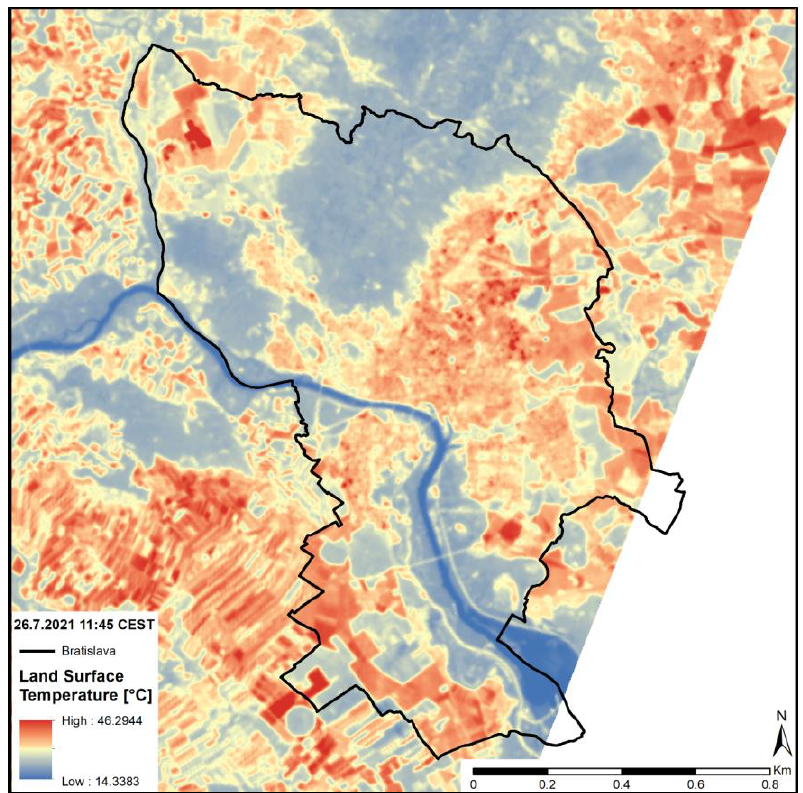
Figure 4. The daytime surface temperature of Bratislava and its surroundings.